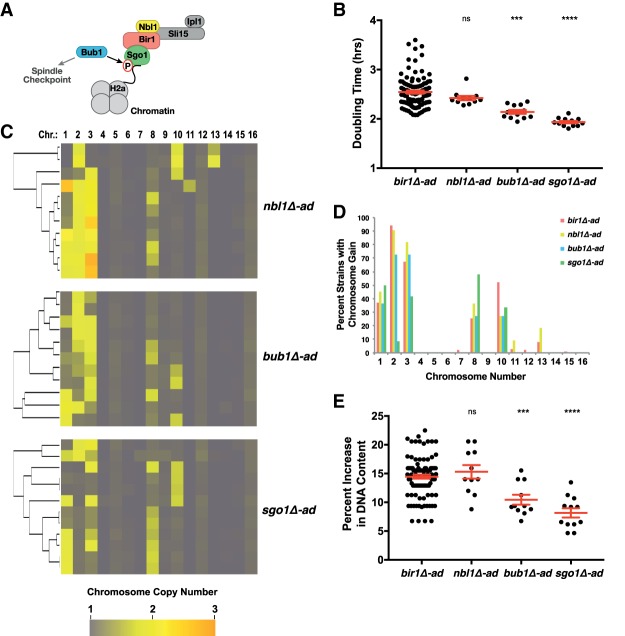
The degree of aneuploidy correlates with the severity of induced CIN. (A) Cartoon of the CPC and the regulators of its localization to chromatin. (B) Cell doubling times for each of the indicated strain types. (C) Heat map visualization of the clustered chromosome copy numbers of the nbl1Δ-ad, bub1Δ-ad, and sgo1Δ-ad strains. (D) Plot of the percentage of strains with a gain of a specific chromosome based on binarization of the data shown in C and Figure 1C. (E) Percentage change in overall DNA content as measured by taking the binarized copy number values of each chromosome, subtracting 1, multiplying each by the fraction of the genome represented by that chromosome, and then summing all of the chromosomes. Mean values and the standard errors are in red. (***) P ≤ 0.0001; (****) P < 0.00001.